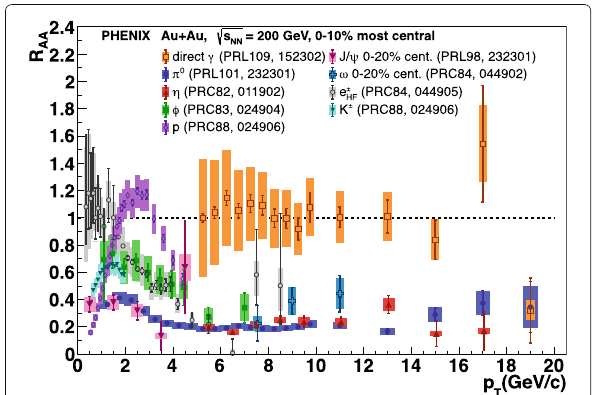
Fig. 3 Nuclear modification factor R AA for various particles as a function of the transverse momentum in Au+Au collisions at 200 GeV from the PHENIX experiment. Figure was taken from Ref. [11] andthereferencescorrespondingtoeachdataareshowninthefigure